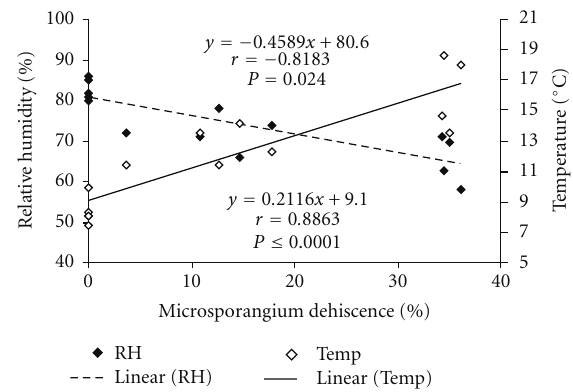
Figure 2: Relationship between microsporangium dehiscence versus temperature and relative